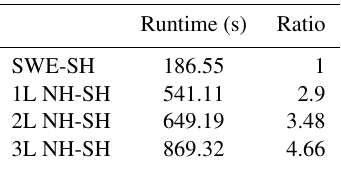
Table 2. Wall-clock times in seconds for the hydrostatic shallow- water Savage–Hutter system (SWE-SH) and the non-hydrostatic GPU implementations. The ratios are with respect to the SWE-SH model